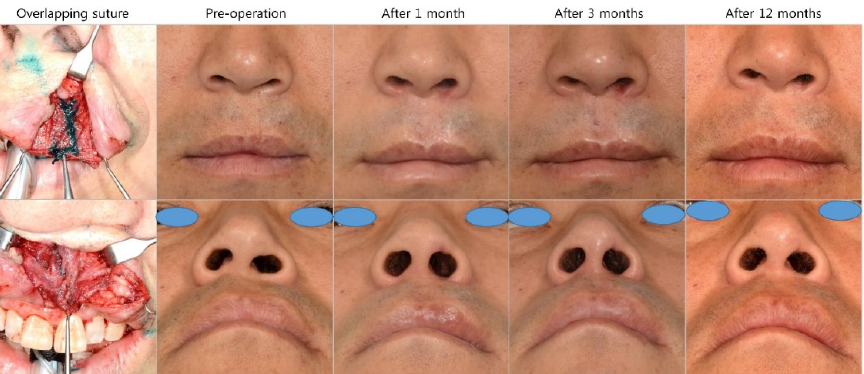
Figure 11. Case of overlapping suture technique. A 44-year-old man underwent secondary correction of cleft lip nasal deformity using overlapping suturing of the OOM. A 5-mm overlap of the OOM from the lateral lip to the medial lip was performed. Augmentation of the philtral column and nasal base was maintained until 3 months after the operation, However, relapse resulting in a vague philtral column and depression of the nasal base was observed 12 months after the surgery.